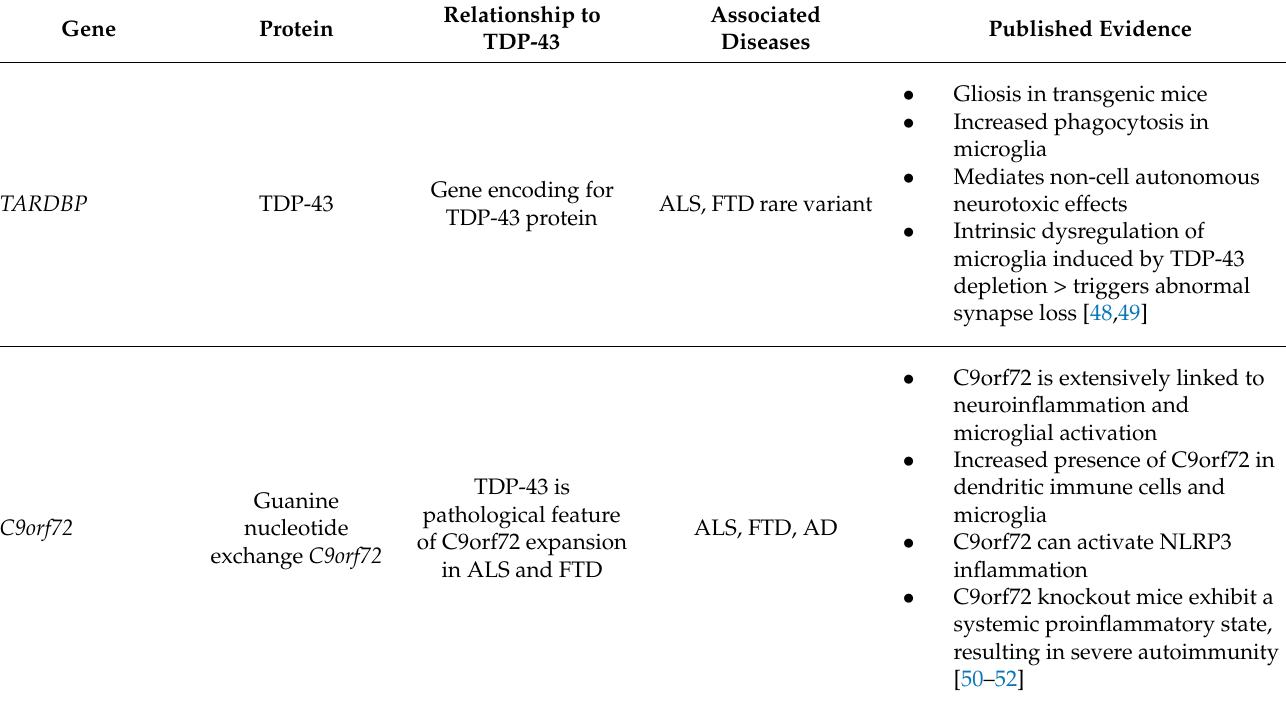
Table 1. Published evidence implicating ALS and FTD causative and susceptibility genes associated with TDP-43 in key immune and inflammatory pathways.